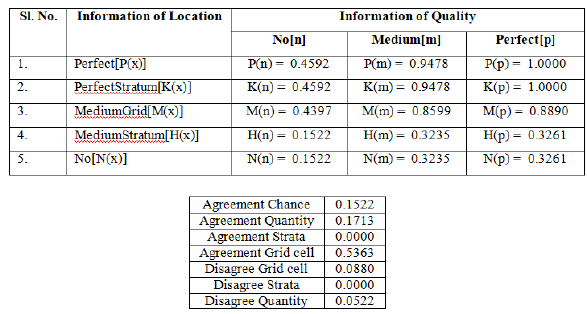
Table 5. Agreement/disagreement according to ability to